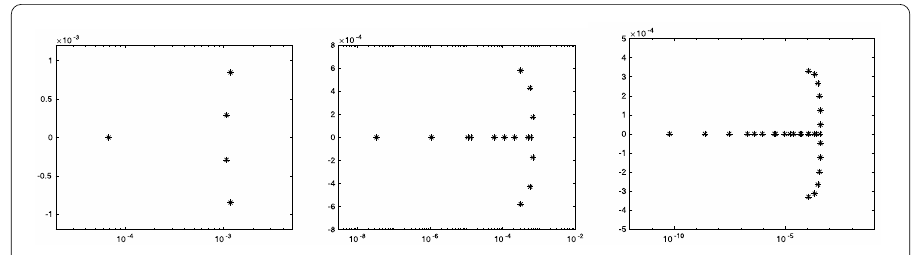
Figure 12 Eigenvalues of U n in the case of an algebraic/square-logarithmic weight function, with exponent α = 5, for n = 5,15,30 (from left to